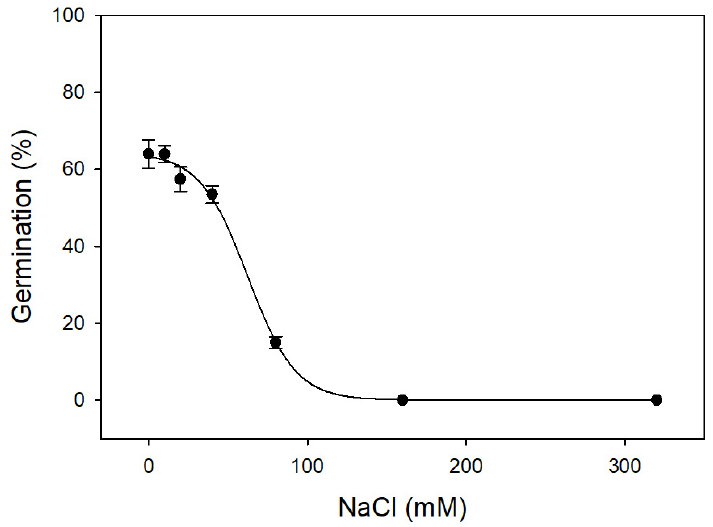
Figure 2. White clover seed germination over time at various NaCl concentrations. Data were re- gressed with the following equation: G = G max /{1 + exp[ − (x − x 0 )/ b ]}. Equation was G = 64.29/{1 + exp[ − (x − 62.40)/ − 15.02]}, standard errors for G max , x 0 , b measured 1.76, 2.46, and 1.76, respectively, R 2 = 0.96, and p < 0.0001. Results were pooled over two experimental runs. Vertical bars represent standard errors ( n = 8). Abbreviation: WAP = weeks after planting.